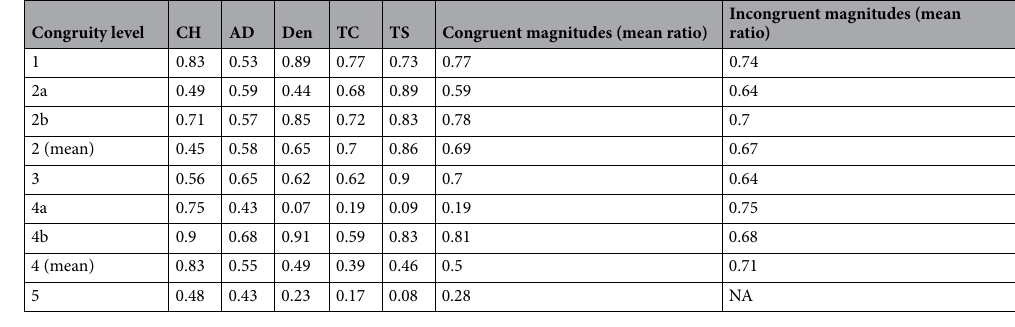
Table 2. Average ratio of non-numerical magnitudes by congruity. Congruent magnitudes are the non- numerical magnitudes of the dot set that are congruent (positively correlate) with numerical quantity, and incongruent magnitudes are the non-numerical magnitudes of the dot set that are incongruent (negatively correlate) with numerical quantity. The values in the cells are the average ratio of the non-numerical ratio magnitude (smaller/larger magnitude). CH convex hull, AD average diameter, Den density, TC total circumference, TS total surface